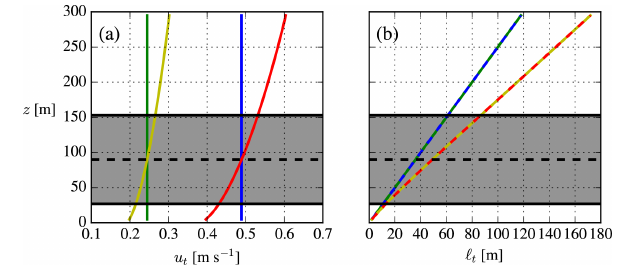
Figure 2. Turbulence scales in the freestream. Same labels as in Fig.